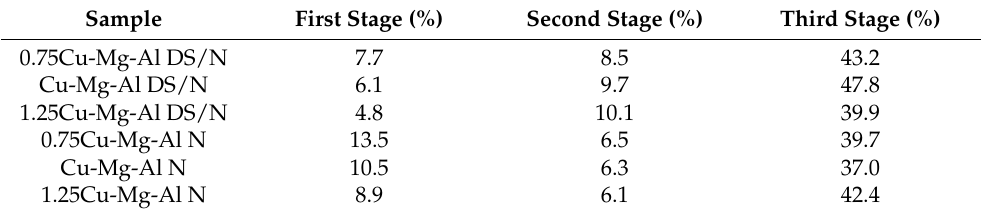
Table 2. Weight loss ratios of xCu-Mg-Al DS/N and xCu-Mg-Al